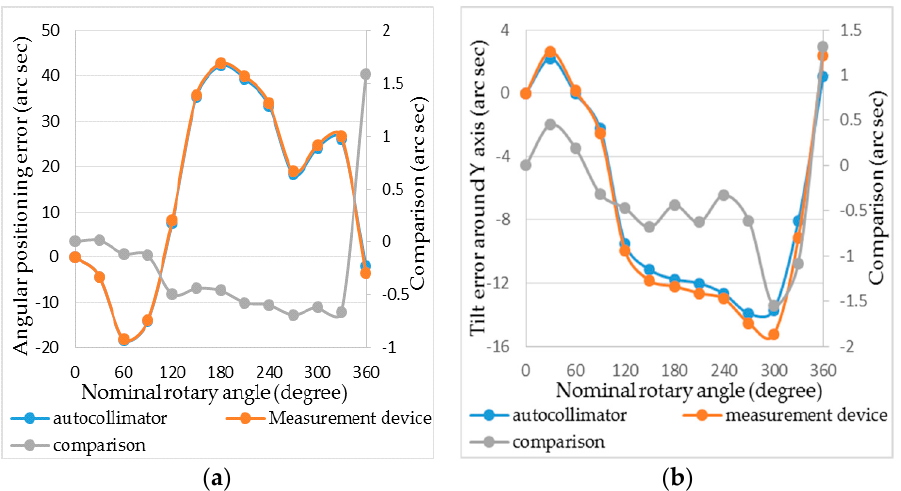
Figure 7. Comparison experiment results for the ( a ) angular positioning error and the ( b ) tilt motion error around the y axis.